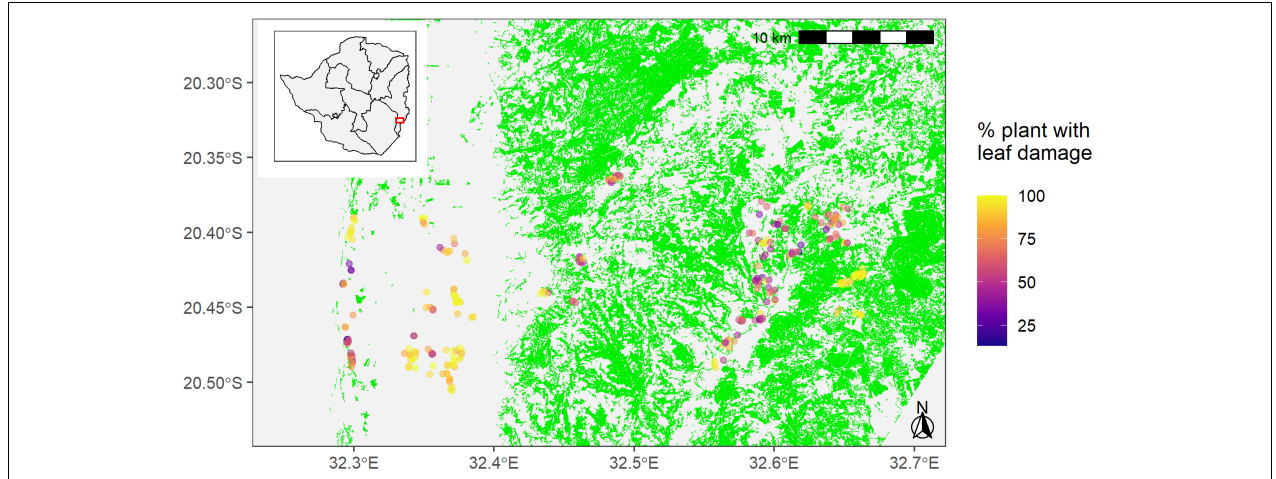
FIGURE 1 | Locations of 278 sampling points in maize fields across Wards 16, 18, and 20 in Chipinge District in Zimbabwe. The green areas are forest patches of at least 0.5 ha. The gray area represents annual crops (mainly maize and sorghum) and grassy fallows. The spatial analysis focused only on forest patches vs. other land covers that included both crops and fallows. Grasses were available throughout the